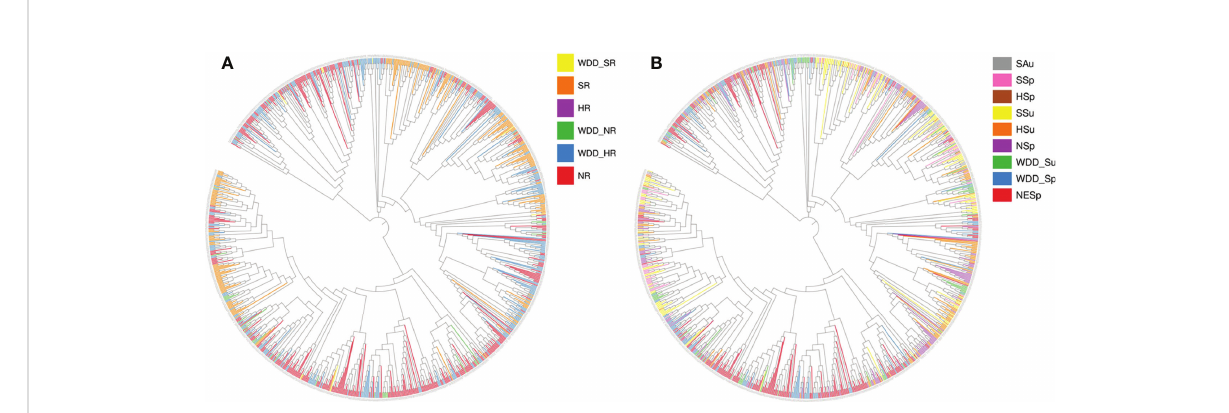
FIGURE 2 951 species construct phylogenetic tree according to geographical distribution and ecological type. (A) Variety Geographical Distribution Evolutionary Tree. WDD_: Oversea_; NR: Northern Region; HR: Central Region; SR: Southern Region (B) Variety Ecotype Evolutionary Tree. SAu, Southern autumn soybean; SSp, Southern spring soybean; HSp, Huanghuai summer soybean; SSu, Southern summer soybean; HSu, Huanghuai summer soybean; NSp, Northern spring soybean; NESp, Northeast Spring Soybeans; WDD_Su, Oversea summer soybean; WDD_Sp, Oversea spring